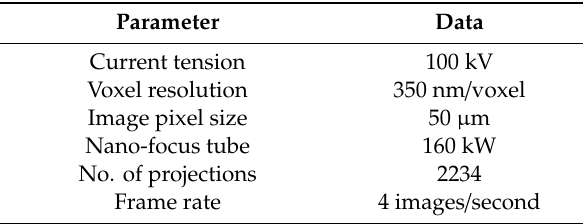
Table 2. Microtomography μ CT scanning parameters to damage analysis.